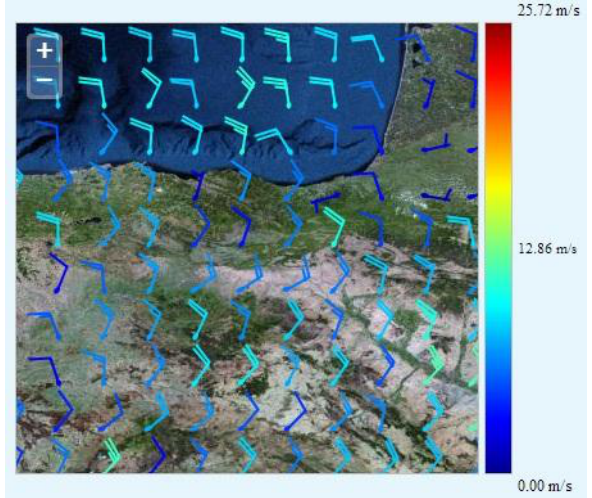
Figure 2. The visualization of extended